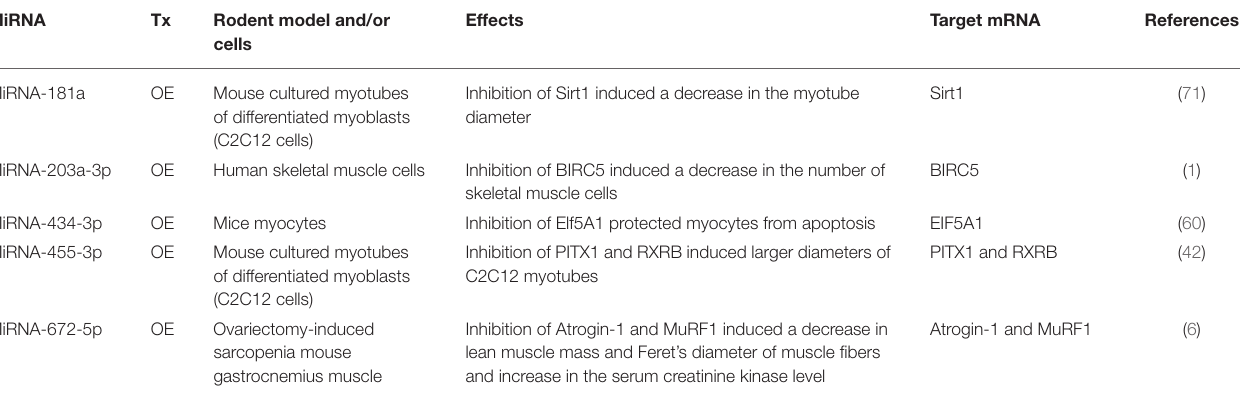
TABLE 3 | Effects of modulation of miRNA expression on frailty and sarcopenia in cells in vitro and rodent frailty and sarcopenia models in vivo .